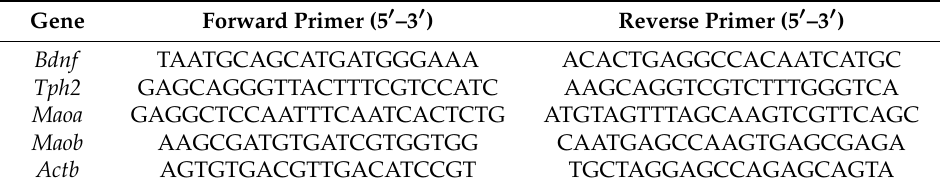
Table 1. Sequences of the primers used in